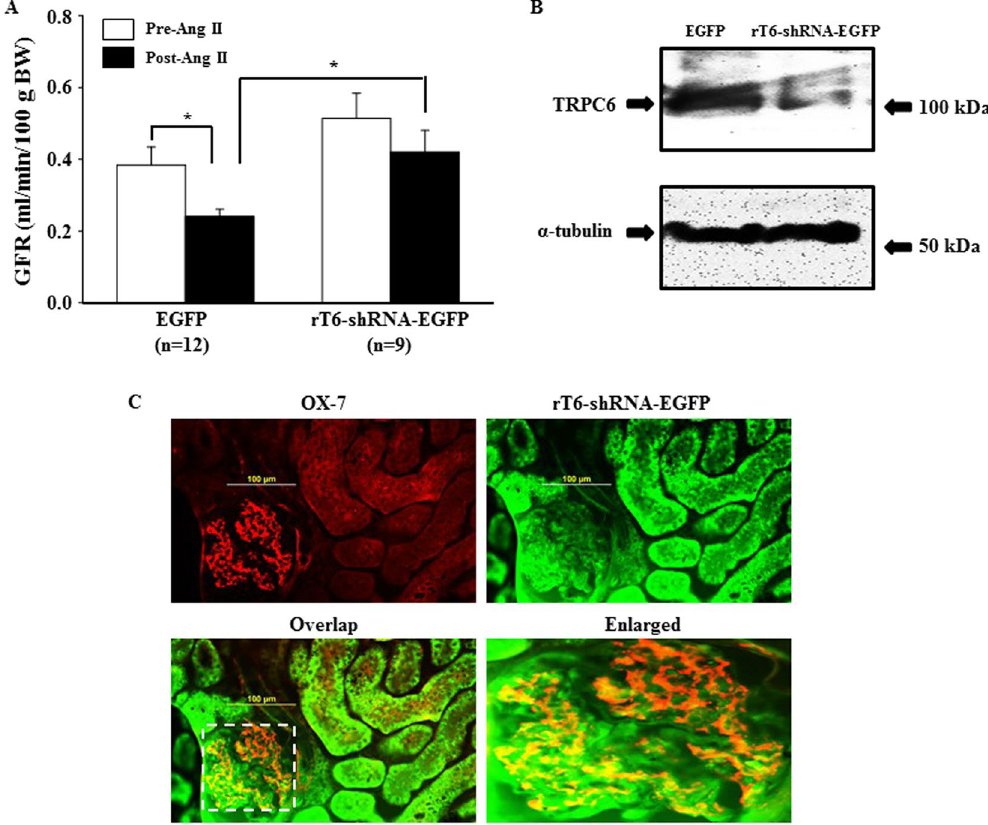
Figure 4. Effect of in vivo knockdown of TRPC6 in kidney on Ang II-induced GFR response in rats. Rats were delivered with EGFP plasmid (Control) or EGFP-tagged shRNA construct against rat TRPC6 (rT6- shRNA-EGFP) into the left kidney. GFR was measured 4 days after treatment. ( A ) GFR in rats treated with EGFP alone and rT6-shRNA-EGFP before (Pre-Ang II) and after (Post-Ang II) Ang II infusion. * Denotes P < 0.05, comparison between the groups as indicated. ( B ) Representative Western blot, showing TRPC6 protein expression in the renal cortical tissues of the left kidney (transfected kidney) from EGFP alone or rT6- shRNA-EGFP treated rats. α -tubulin was used as a loading control. ( C ) Immunofluorescence staining, showing distribution of rT6-shRNA-EGFP (green) in kidney. Glomerular MCs were labeled with OX-7, shown by red signals. Positively transfected MCs are indicated by yellow fluorescence in the panels of Overlap. The right bottom panel is an enlarged image of the region indicated by a rectangle in the panel of